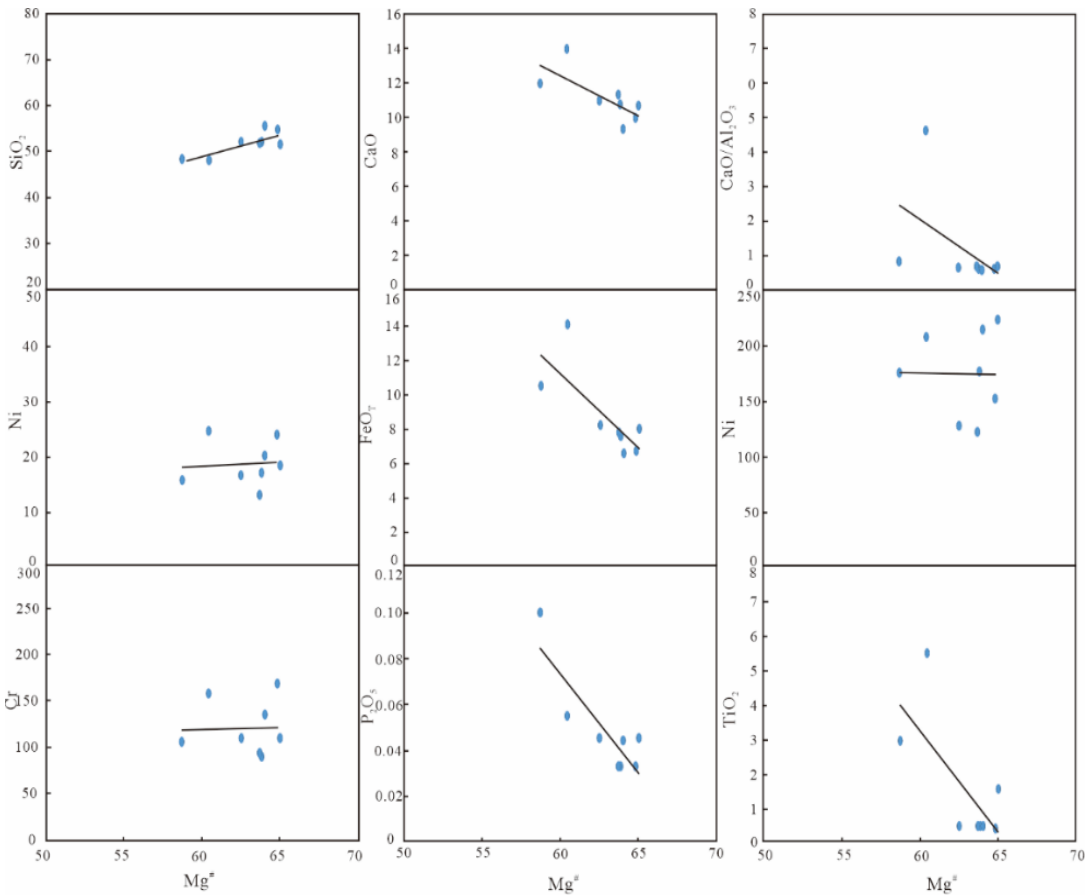
Figure 8. Variation diagrams of SiO 2 , TiO 2 , FeO T , CaO, P 2 O 5 , Cr, Ni, CaO/Al 2 O 3 , and Sc/Y versus Mg # for Yuejingshan gabbro samples.